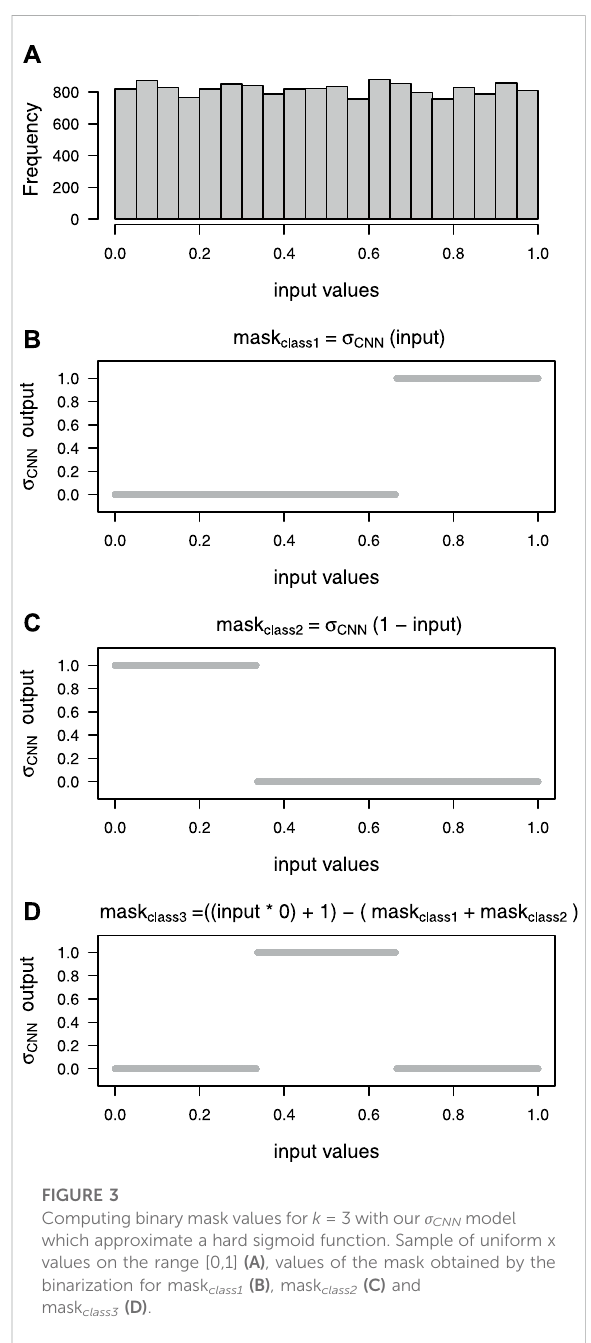
FIGURE 3 Computing binary mask values for k = 3 with our σ CNN model which approximate a hard sigmoid function. Sample of uniform x values on the range [0,1] (A) , values of the mask obtained by the binarization for mask class1 (B) , mask class2 (C) and mask class3 (D)